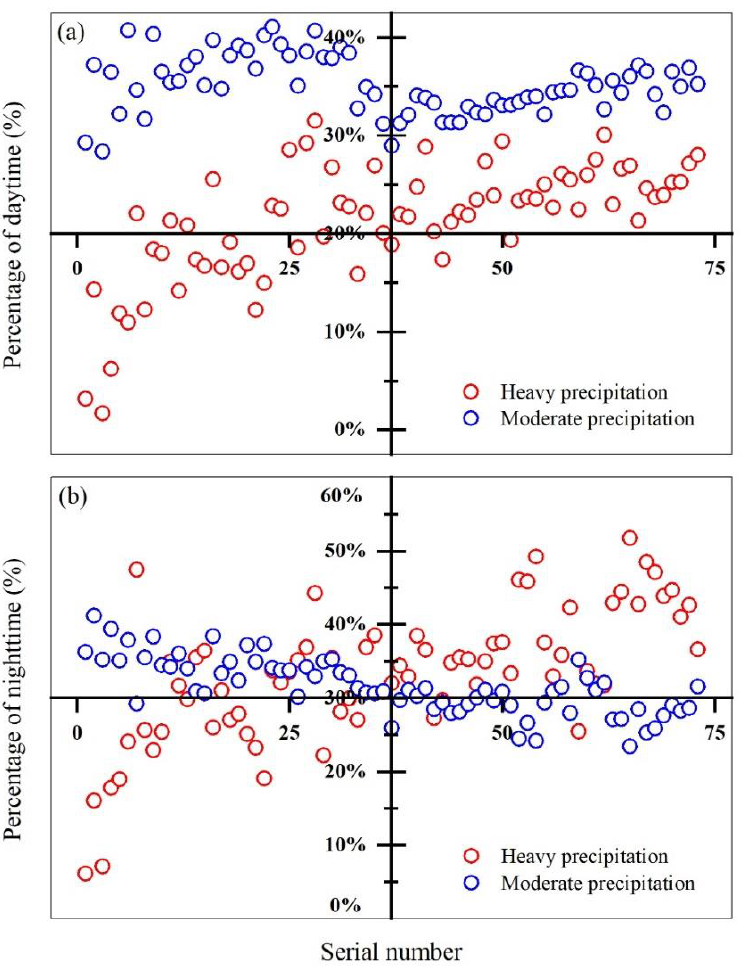
Figure 8. The proportion of heavy precipitation and moderate precipitation in the daytime and night-time.